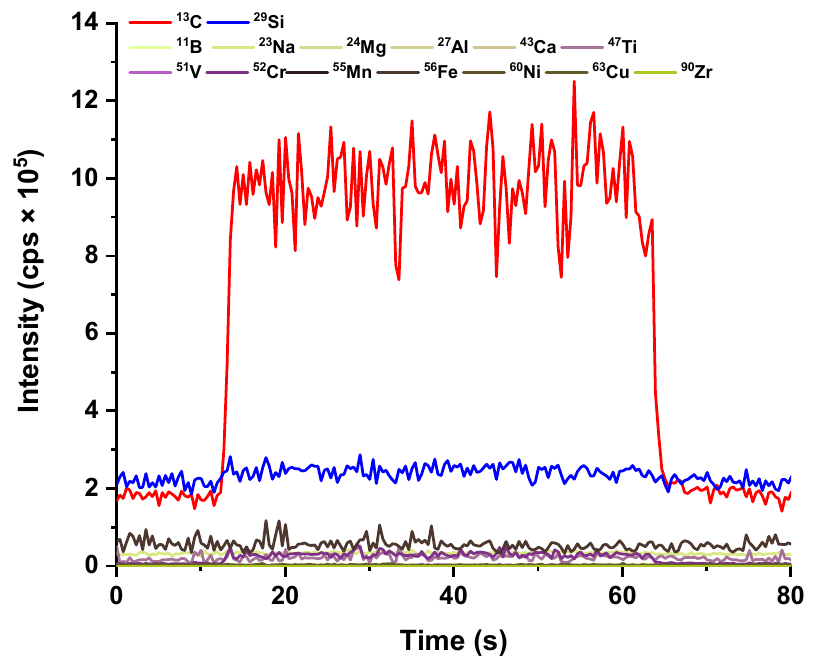
Figure 2. Ablation signals recorded by analyzing the epoxy resin used in this study. Spot size = 120 µm, length = 1 mm, scanning speed = 20 µm/s, frequency = 10 Hz and fluence = 3.8 J/cm 2 .